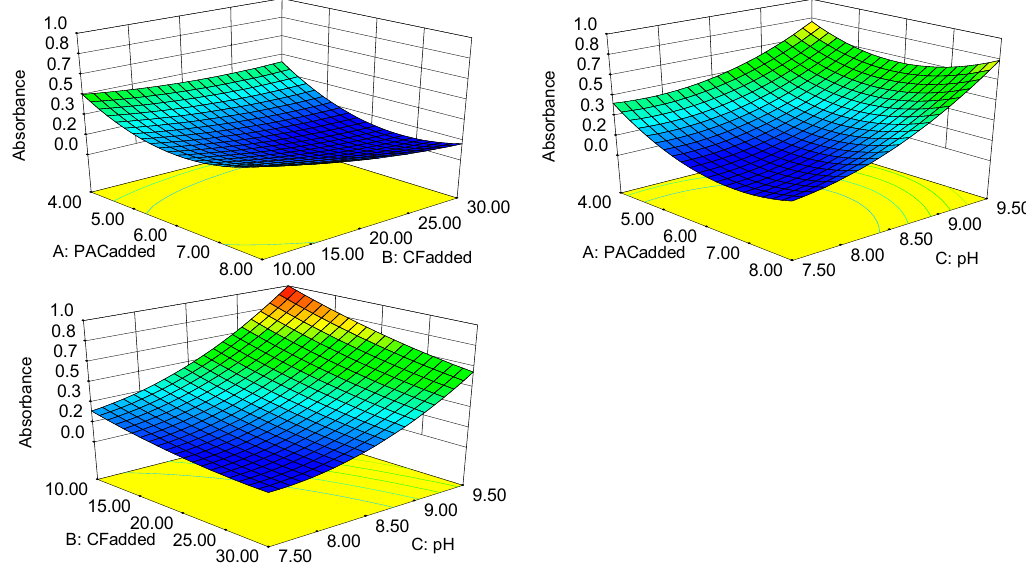
Figure 2. Response surface of the absorbance values.